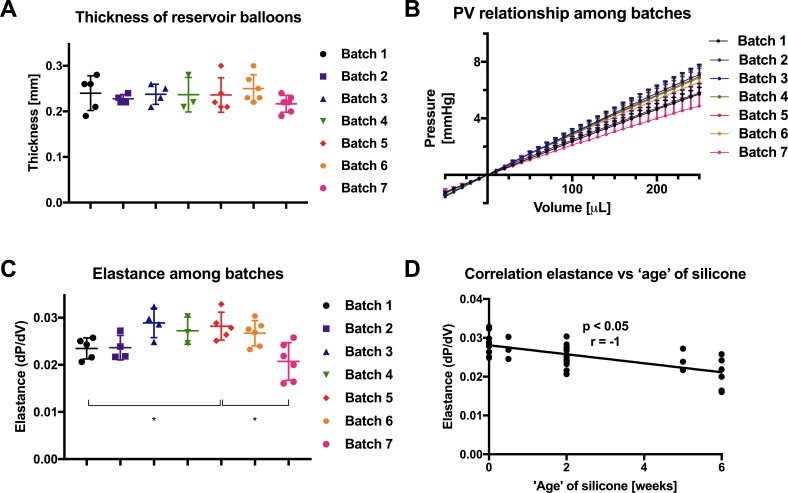
Baseline characteristics of reservoir balloons.(A) Thickness of reservoir balloons (RB); (B) PV relationship of RB according to batch; (C) elastance of RB; (D) negative correlation between the elastance of the RB and silicone ‘age’. Data are normalized to initial pressure (volume = 0) and expressed as mean ± SD. * p<0.05. n = 3–6 per group.